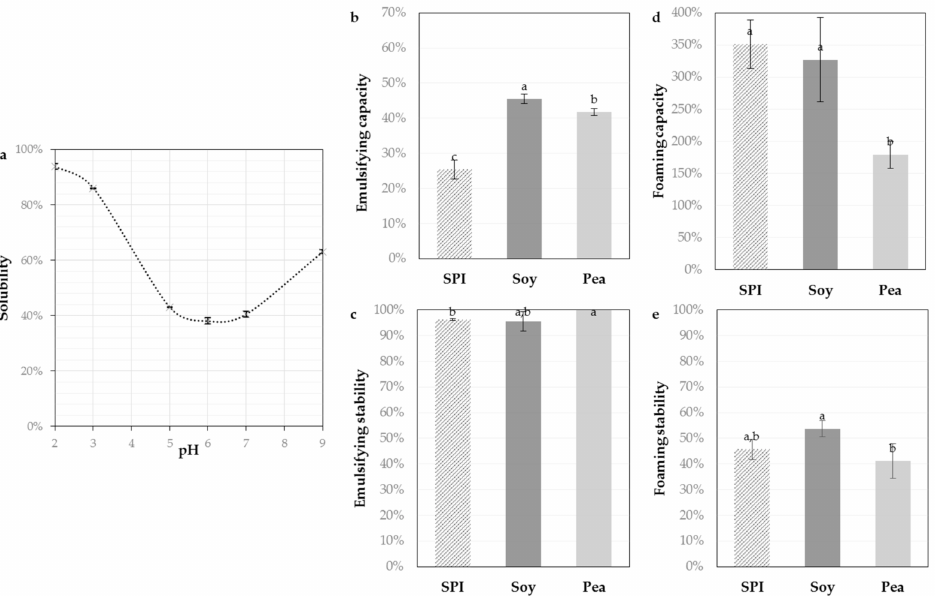
Figure 1. Solubility of sunflower protein isolate (SPI, 5 g L − 1 ) as a function of pH ranging from 2.0 to 9.0 at 20 ◦ C measured by the Kjeldahl method ( a ) and the techno-functional properties: emulsifying capacities ( b ), emulsifying stabilities ( c ), foaming capacities ( d ) and foaming stabilities ( e ) compared to a commercial pea isolate (Pea) and a hydrolysate of soy (Soy). Values are means ( n = 3) and the error bars are the standard deviations. Samples with a common letter are not different ( p >